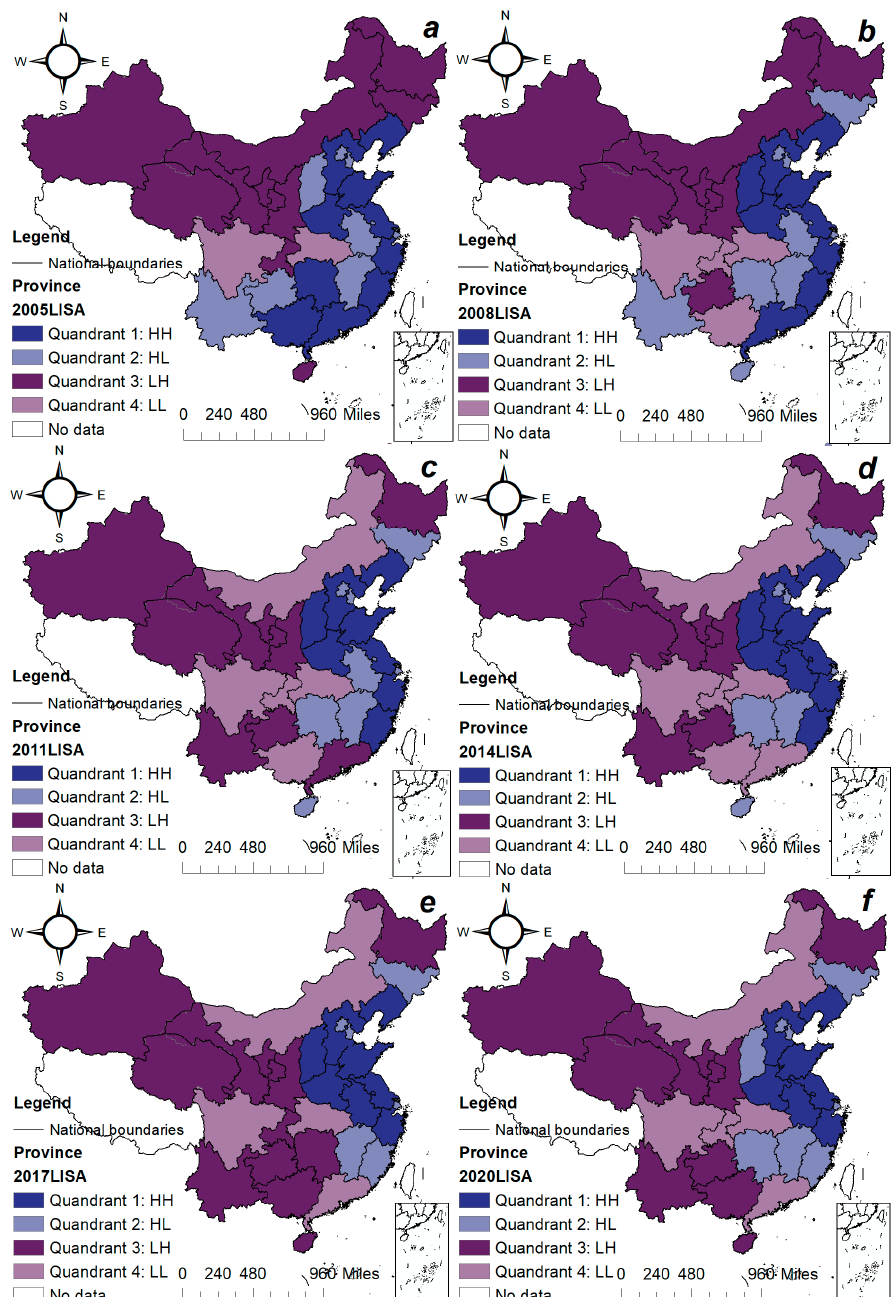
Figure 3. The global Moran scatter displayed spatial clustering in different years. Notes: ( a – f ) China’s environmental pollution agglomeration in 2005, 2008, 2011, 2014, 2017 and 2020, respec- tively.